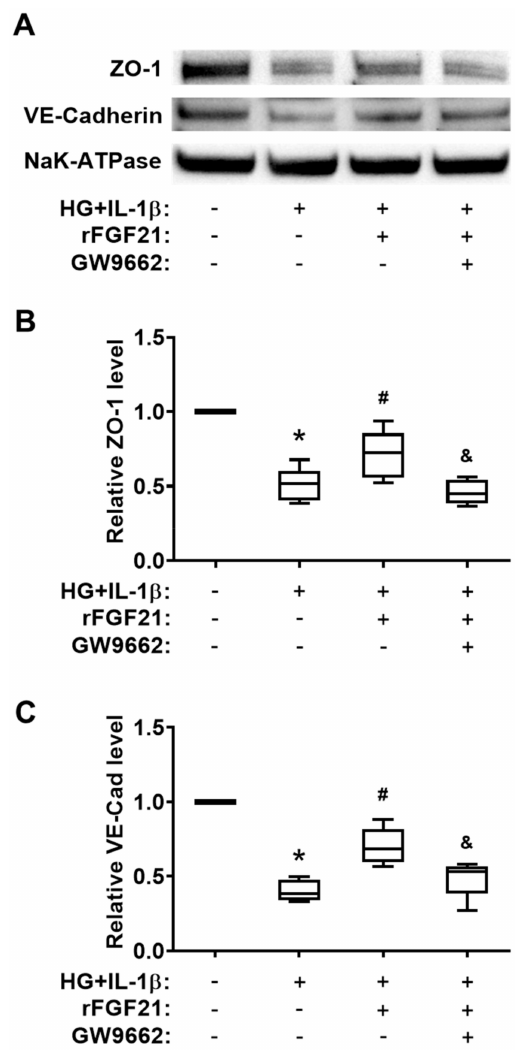
Figure 5. rFGF21 increases junction protein expression via promoting PPAR γ in cultured HBMECs. HBMECs were cultured under hyperglycemia for 3 days and then exposed to IL-1 β for 16 h (HG + IL-1 β ), and membrane proteins fraction was isolated for Western blots. ( A ) Representative Western blot gel images of ZO-1 and VE-cadherin expression. ( B ) Relative fold change of junction protein ZO-1 in cultured HBMECs. ( C ) Relative fold change of junction protein VE-cadherin in cultured HBMECs. Data are illustrated as box-plots with the median, lower and upper quartiles, minimal and maximal value ( n = 5 per group). * p < 0.05 for injured vs. normal; # p < 0.05 for injured + rFGF21 vs. injured; & p < 0.05 for injured + rFGF21 + GW9662 vs. injured +